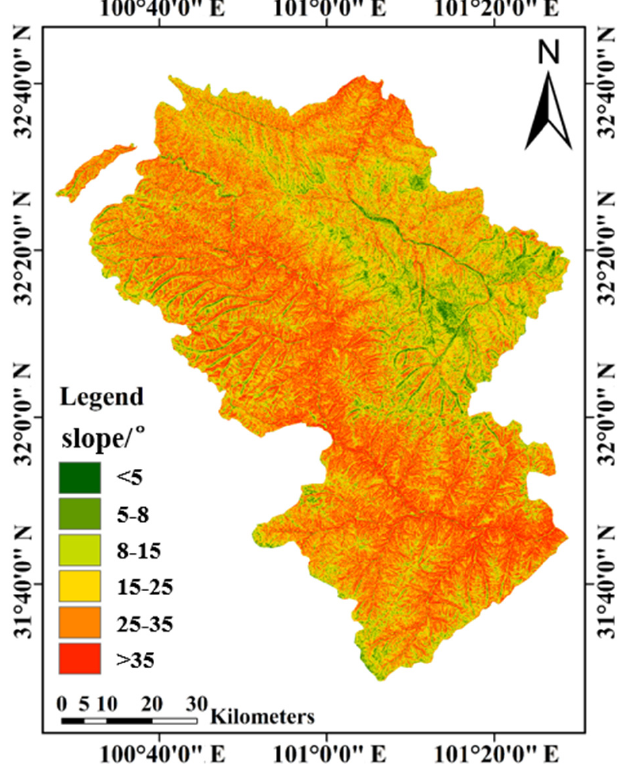
Figure 4. The slope of Rangtang County.